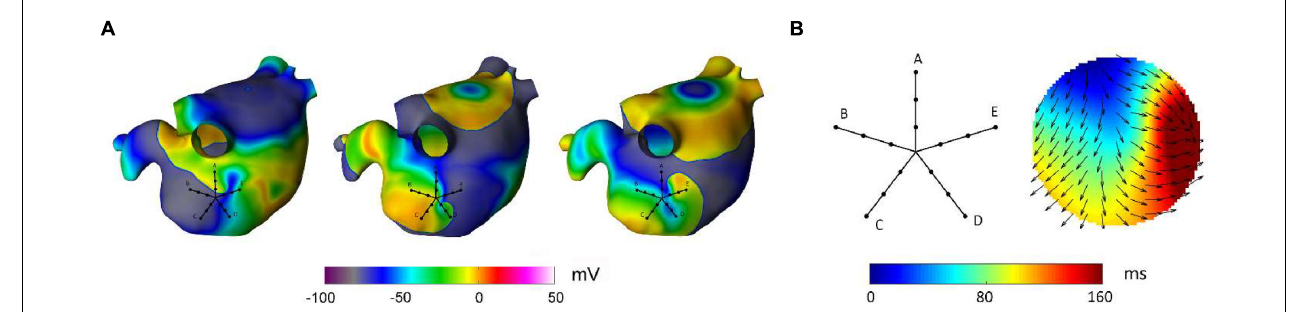
FIGURE 9 | Reconstruction of a rotational pattern by radial basis functions during simulated atrial fibrillation in a realistic left atrial model. In panel (A) , the sequential snapshots of the membrane voltage show the presence of a transient rotor, which activates the PentaRay mapping area in a counterclockwise direction. Panel (B) shows the activation map reconstructed from RBF interpolation of the activation times recorded at the PentaRay bipoles, with the normalized conduction velocity vectors indicating the direction of wave propagation. The RBF activation map tracked the activation sequence, but it was not able to reproduce the head-meet-tail part of the circuit (B)